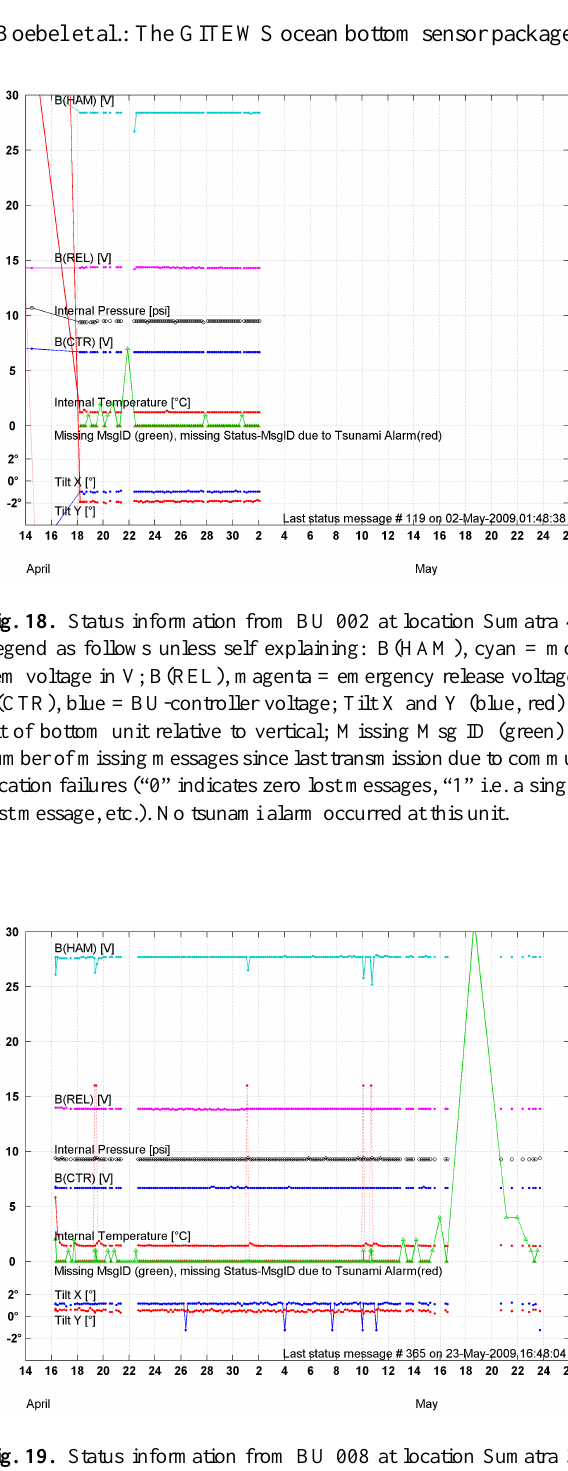
Fig. 19. Status information from BU 008 at location Sumatra 3. Legend as in Fig. 18. Red peaks at “16”: Tsunami alarm with (nom- inally) 16 tsunami